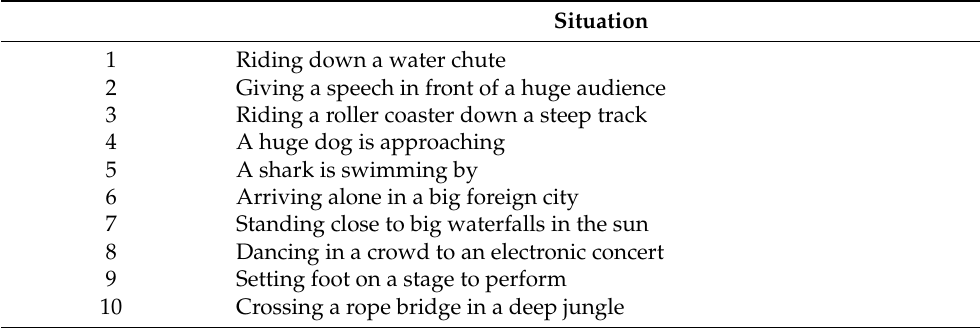
Table 1. Ambiguous situational stimuli of the SOFE task to induce either happiness or fear. Photographs from a first-person perspective were accompanied by a short written description of the